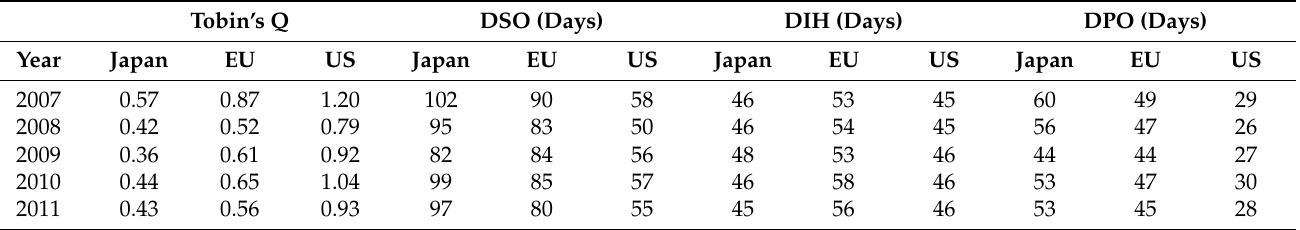
Table 3. Median of Tobin’s Q, days sales outstanding ( DSO ), days inventory held ( DIH ) and